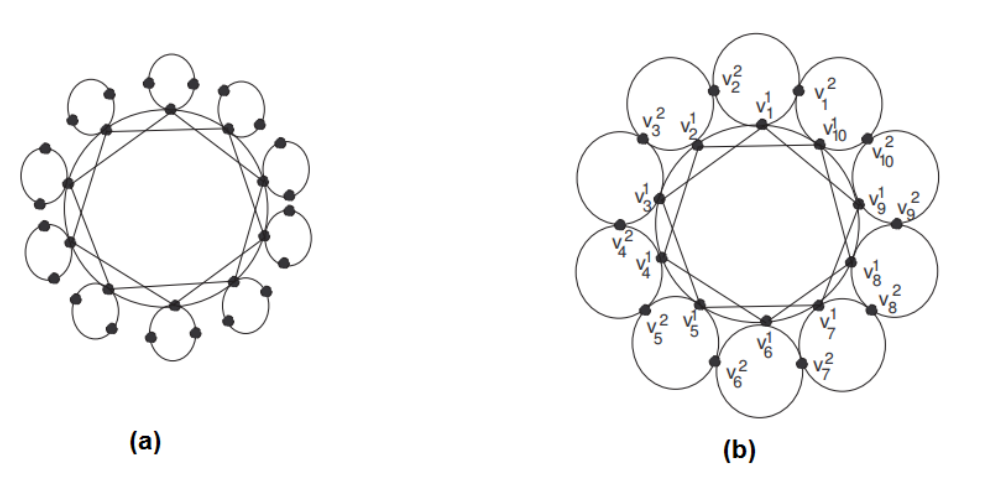
Figure 3. ( a ) The graph of H 4,10 ( C 3 ) ; ( b ) The graph of H 4,10 ( C 3 ) c